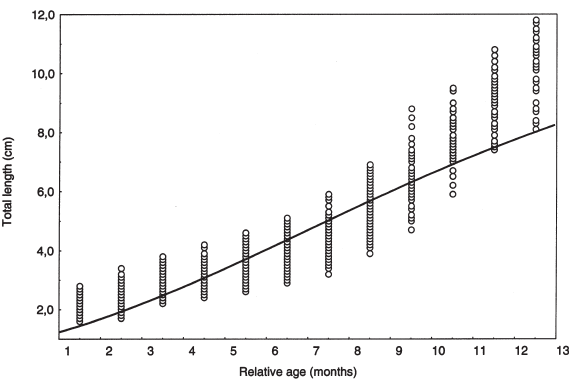
F IG . 3. – Gompertz growth curve of juvenile S. salpa from the Adriatic Sea (Lt = 12.5 * e -2.674 * e (-0.144 * t)